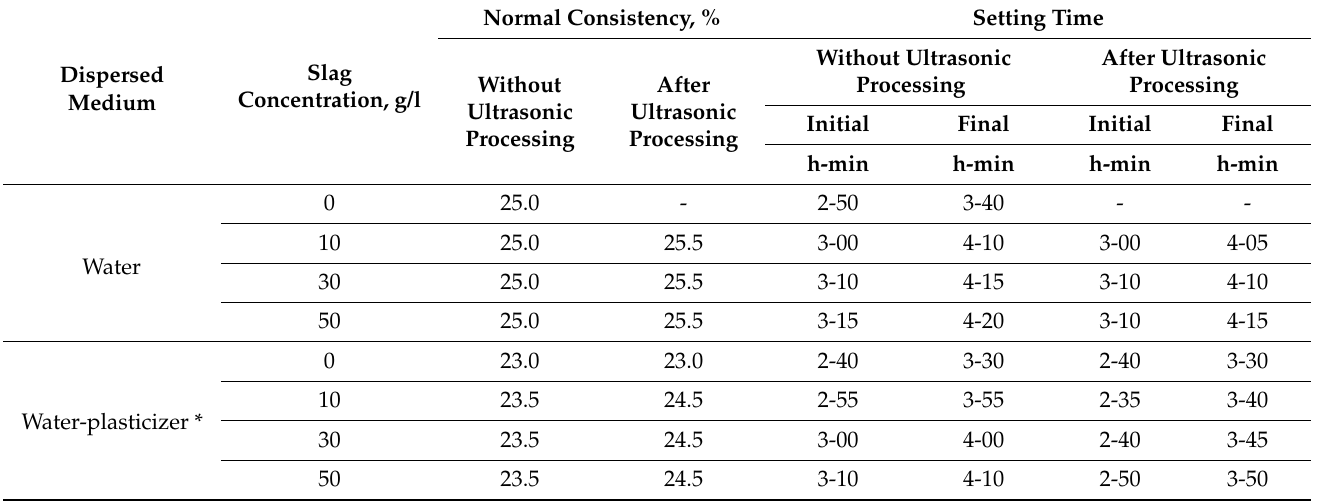
Table 24. Construction and technical properties of cement mortar based on SPC with slag